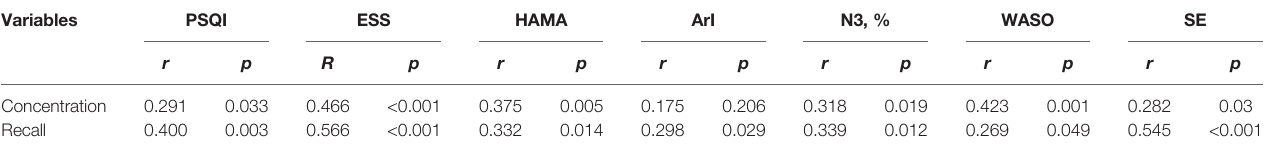
TABLE 5 | Correlation analysis of sleep improvement and cognitive improvement. Variables